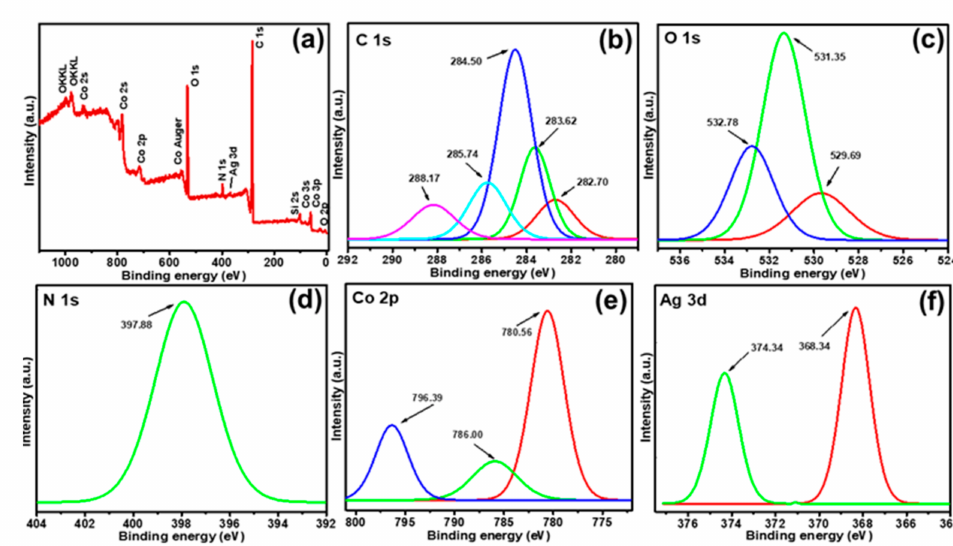
Figure 6. ( a ) XPS survey scan spectra of Ag / Co 3 O 4 @PANI. The representation of high-resolution spectra of C 1s ( b ), O 1s ( c ), N 1s ( d ), Co 2p 3 / 2 ( e ) and ( f ) Ag 3d